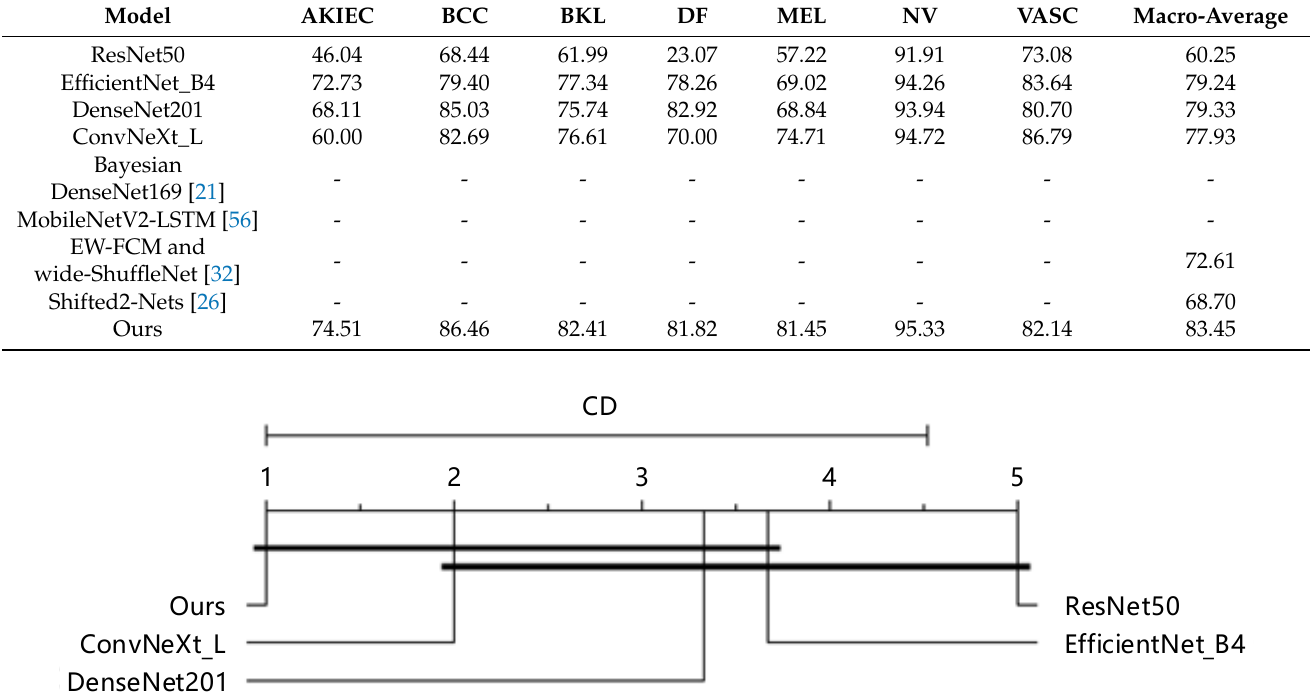
Table 12. The f1-score of each model on the public dataset HAM10000 (test set of 2000 images); the missing values of indicators are replaced by “-”, and the unit is %.